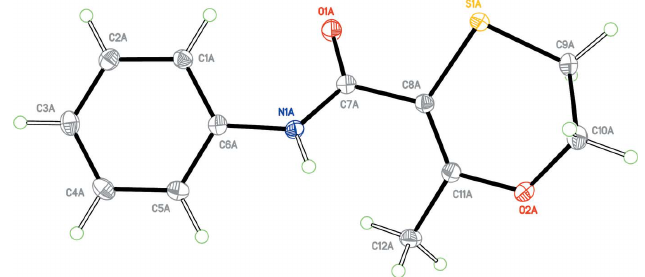
Figure 1 View of molecule A of the asymmetric unit of form 1 with the atom labelling scheme. Displacement ellipsoids are drawn at the 50% probability level.